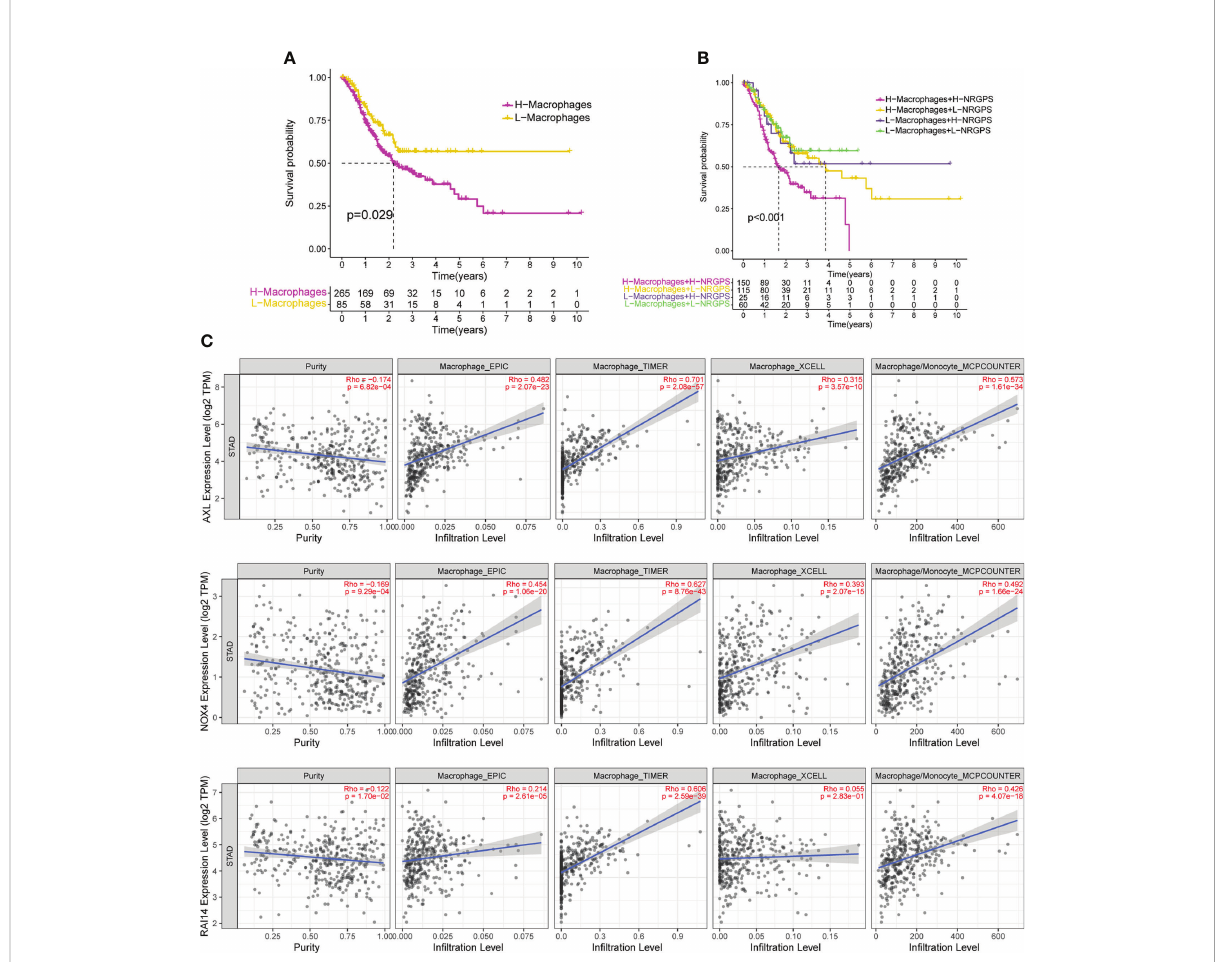
FIGURE 9 NRGPS and macrophages in TME were analyzed. (A) Difference in survival time between high- and low-macrophage groups (ssGSEA algorithm). (B) Survival analysis of macrophage combined NRGPS (ssGSEA algorithm). (C) EPIC, TIMER, XCELL and MCPCOUNTER algorithms were used to analyze the correlation between the three candidate genes and macrophages. NRGPS, necroptosis-related gene prognostic score; TME, tumor